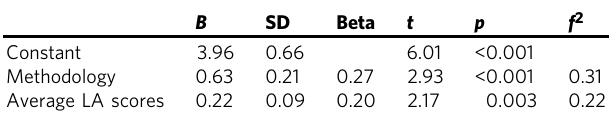
Table 3 Multilinear regression analysis summary for LA and methodology predicting academic achievement in historical thinking.